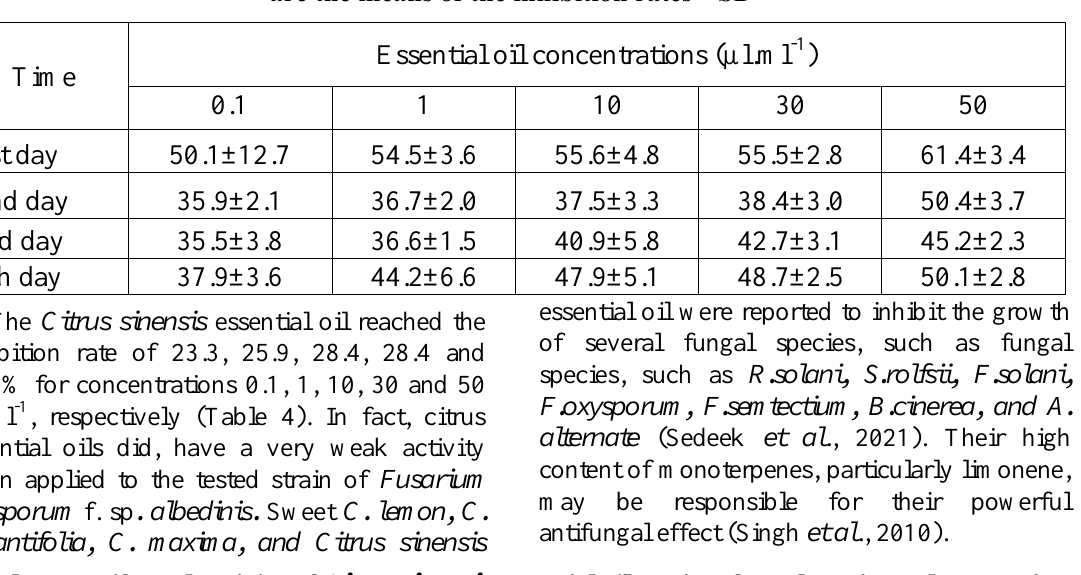
Table 3. Antifungal activity of Foeniculum vulgare essential oïl against fungal strain. Values